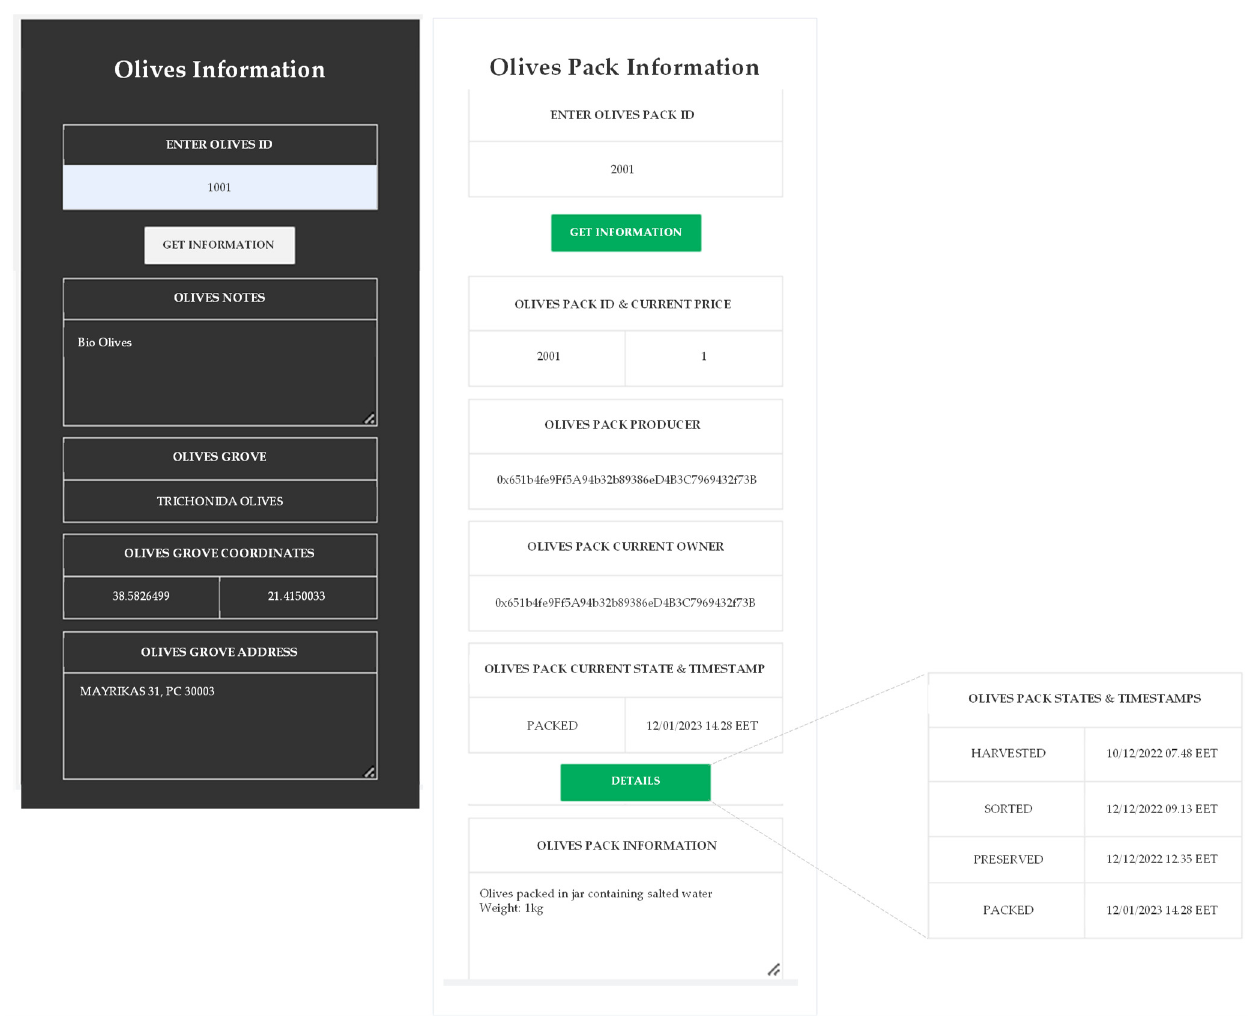
Figure 7. Tracking of Table Olives.